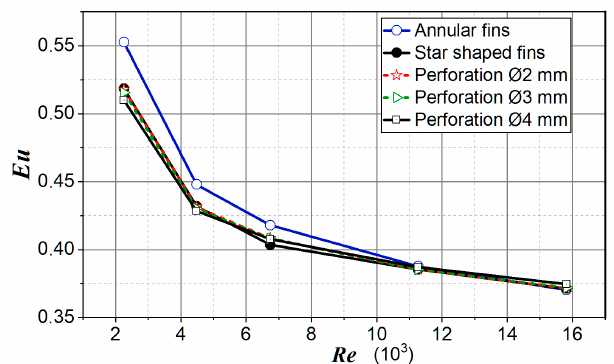
Figure 12. Euler number for analyzed cases.